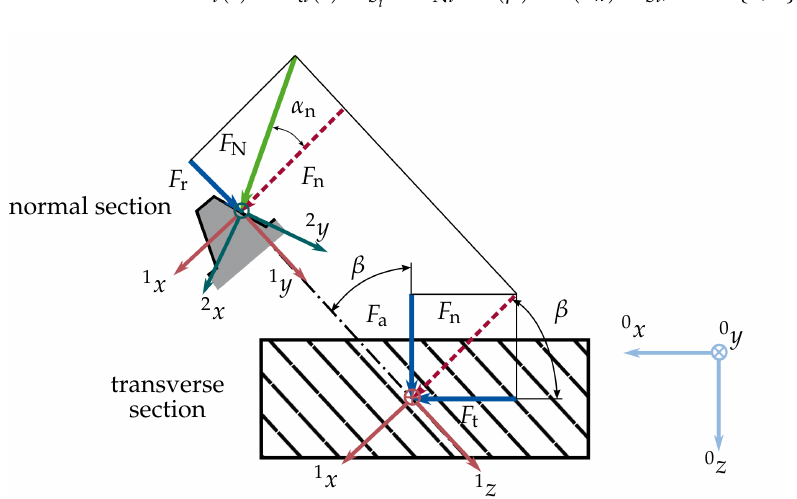
Figure 3. Tooth forces with extension of the coordinate systems